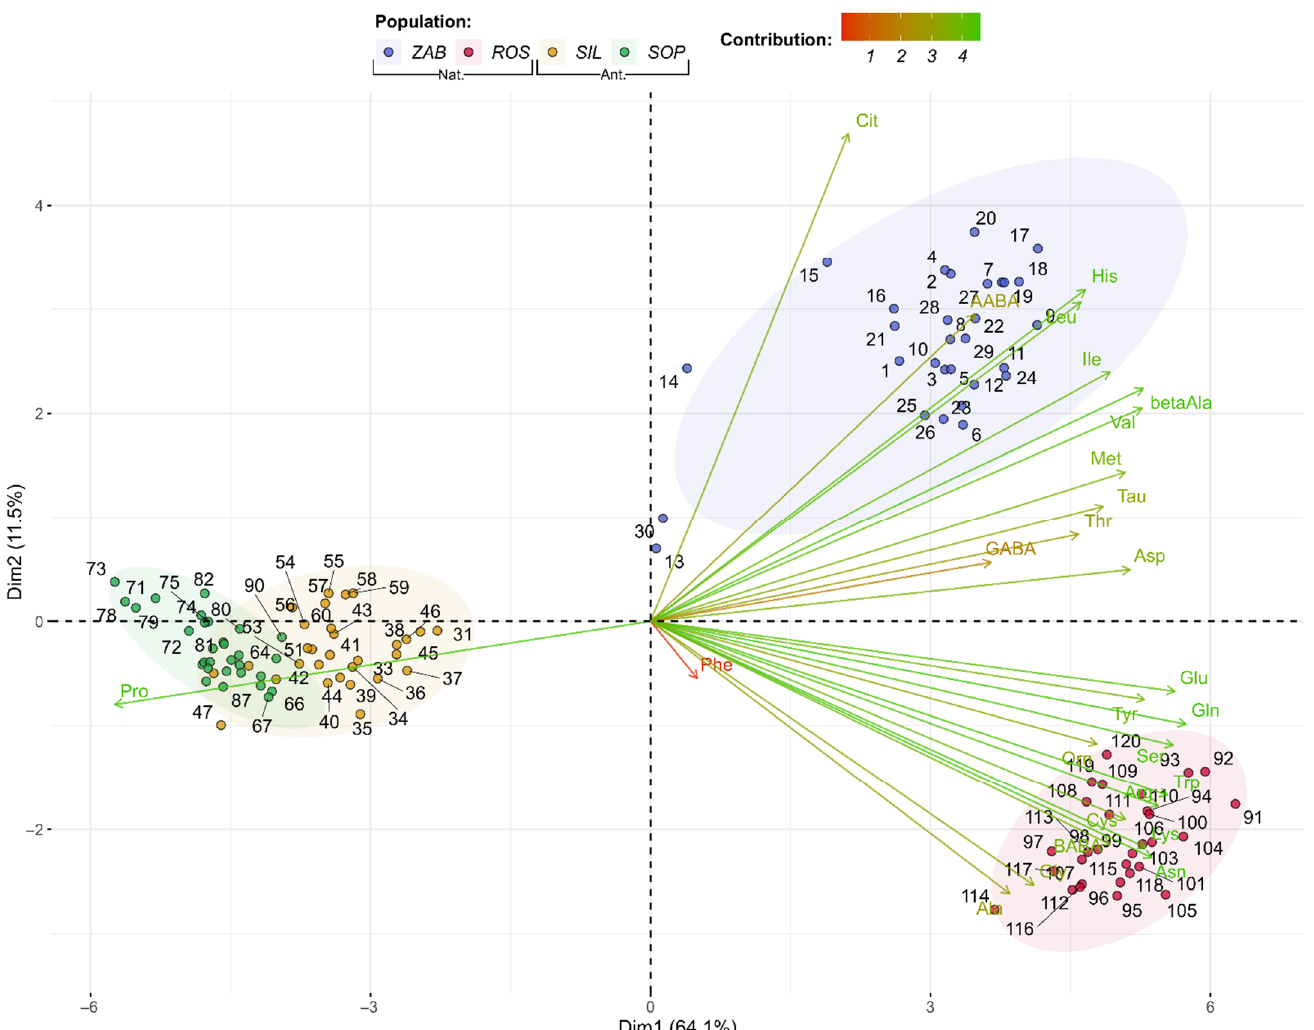
Figure 4. Biplot of amino acid profiles for Epipactis palustris natural (Nat.) and anthropogenic (Ant.) populations, showing the first two dimensions or factors (Dim1-2) of PCA that, together, explain 75.52% of the variance. Biplot vectors indicate the strength and direction of factor loading for the first two factors. Individuals (populations) are color-coded by population. Ellipses around the individuals show assumed 95% multivariate normal distribution. Table 2. The concentration of amino acids (μM) and total amount of amino acids (mg/mL) in Epipactis palustris nectar. The number of classes represents the effect of amino acids on insect chemoreceptors: I—no effect; II—inhibition of chemore- ceptors; III—stimulate the salt cell; IV—the ability to stimulate the sugar cell. Data ( n = 30) represent the mean ( (cid:1876) ) ± stand- ard error (SE), lower quartile (Q 1 ), median (Q 2 ), upper quartile (Q 3 ), and interquartile range (IQR). Different lowercase letters indicate statistically significant differences, according to Tukey’s post-hoc test ( p < 0.05). Different uppercase letters indicate statistically significant differences according to the pairwise Wilcoxon Rank Sum test with Benjamini–Hochberg adjustment ( p < 0.05). ND—not detected. Additional comparisons were shown only when populations within Nat. or Ant. (or both) do not differ significantly.